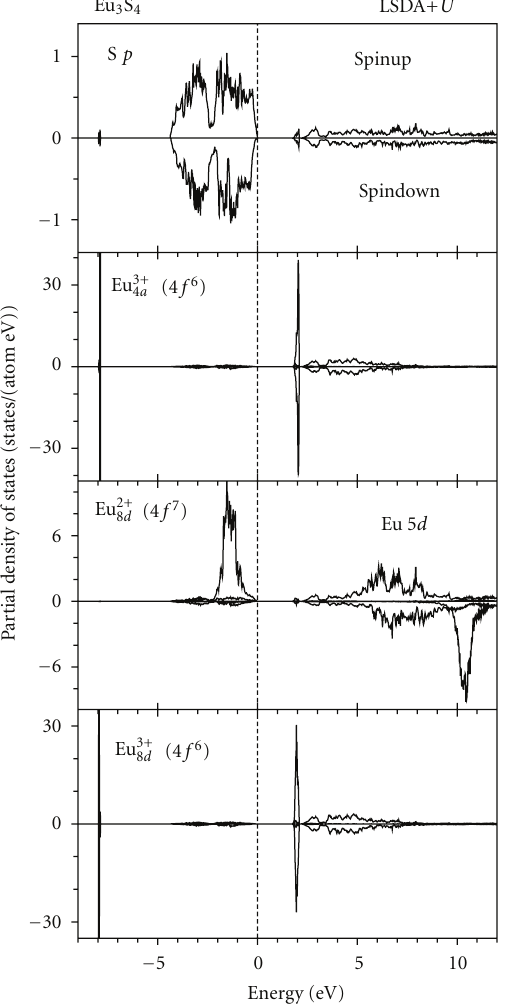
Figure 86: The partial density of states (DOS) (in states/(atom eV)) of Eu 3 S 4 in I 42 d phase calculated in LSDA+U approximation [455].